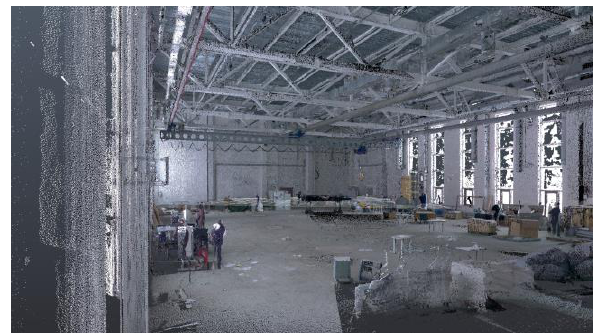
Figure 8. Point cloud for existed industrial site case study